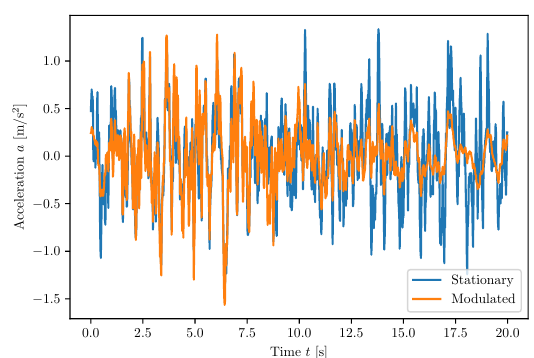
Figure 2. Design response spectrum, computed re- sponse spectrum, location of frequencies to calculate parameters of Rayleigh damping.